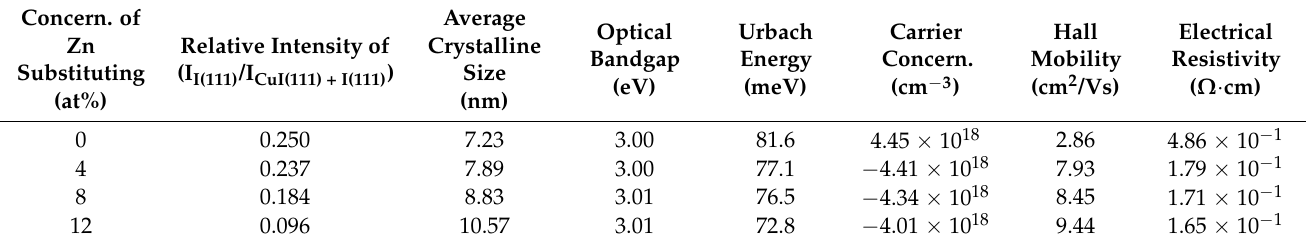
Table 1. Comparison of microstructural, optical and electrical characteristics of solution-processed Zn-substituted CuI thin